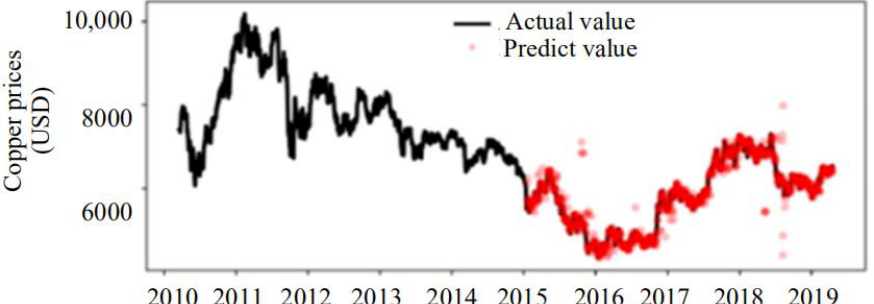
Table 3. Metal grade and smelting recovery rate in the CSU2019 model.